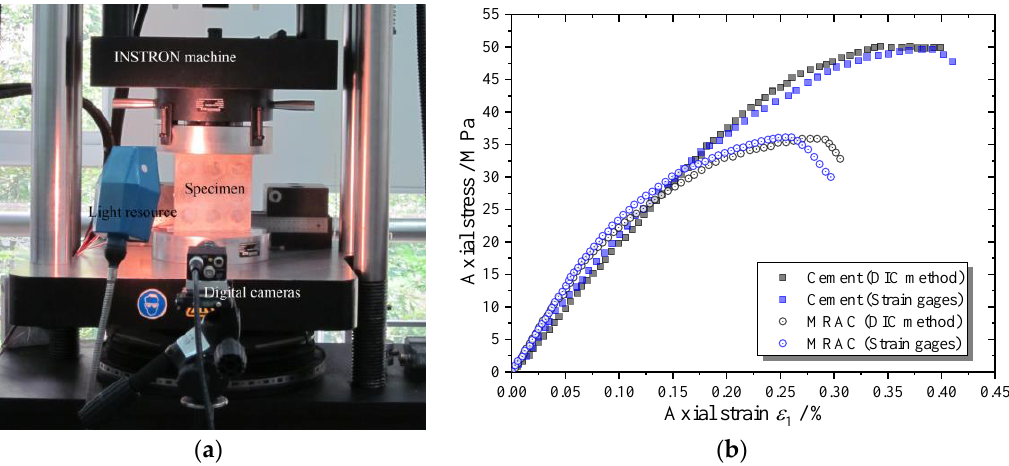
Figure 4. Setup for compression test and digital image correlation (DIC) measurements ( a ) equipment;